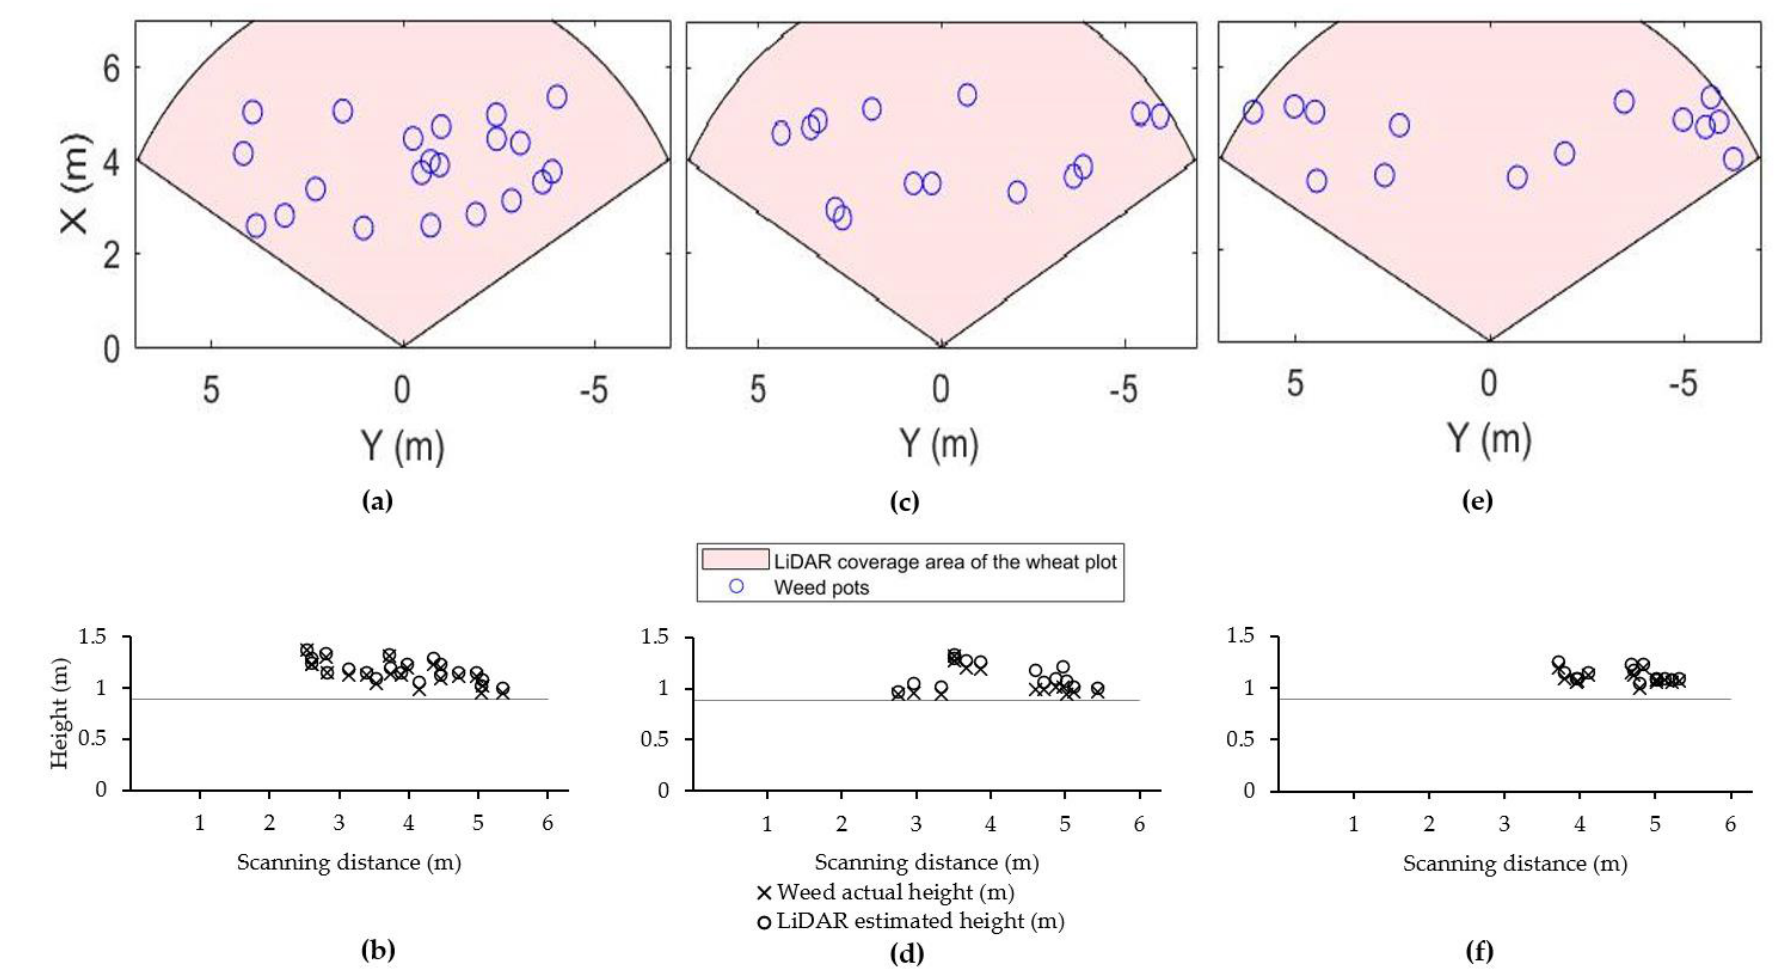
Figure 7. Illustration of the weed pots containing Avena fatua ( a ), Sonchus oleraceus ( c ), mix weed pots ( e ) in the wheat plot; and comparison of weed heights and the LiDAR-estimated heights for Avena fatua ( b ), Sonchus oleraceus ( d ), mix weeds ( f ). The scanning distance shows the width of the wheat plot covered by the LiDAR. The LiDAR was mounted on a stand at 1.08 m height above the ground pointing to the plot at an angle of 15 ◦ below the horizontal. The horizontal line at 0.89 m height shows the 99-percentile of wheat